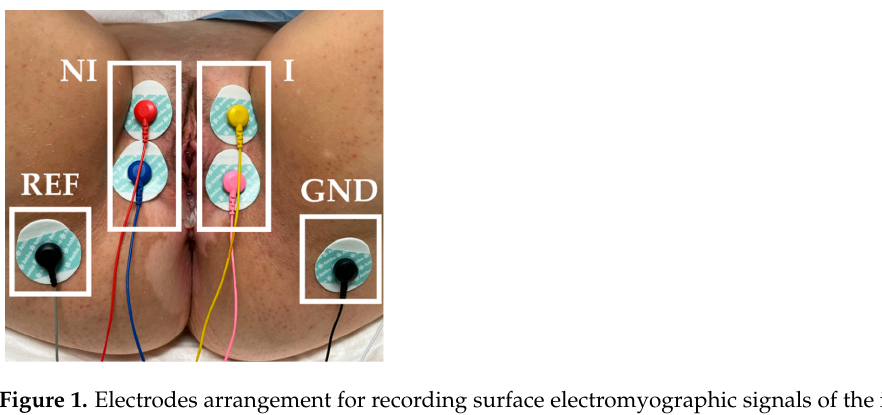
Figure 1. Electrodes arrangement for recording surface electromyographic signals of the infiltrated (I) and non-infiltrated (NI) sides of the pelvic floor muscle. (REF: reference electrode. GND: ground